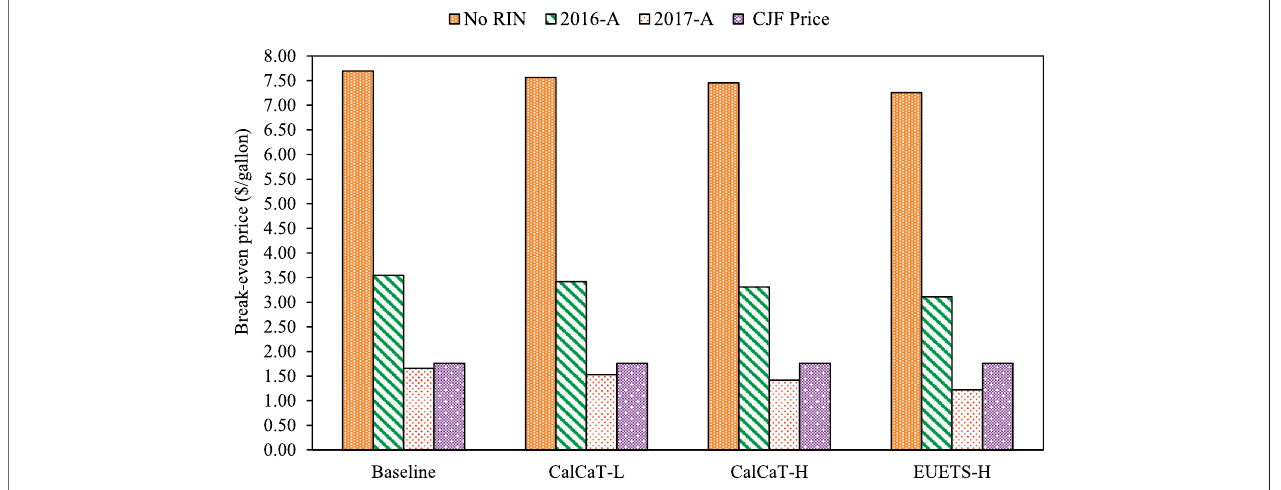
FIGURE 5 | SAF break-even prices with RIN credits and revenues of co-products. Note: 2016-A and 2017-A denote RIN credits for cellulosic biofuel based on averagepricefor2016and2017,respectively.CalCaT-L,CalCaT-HandEUETS-HdenotelowestcarbonpriceintheCaliforniaCap-and-Tradeprogram,highestcarbon price in the California Cap-and-Trade program and highest carbon price in the European Union Emission Trading System,